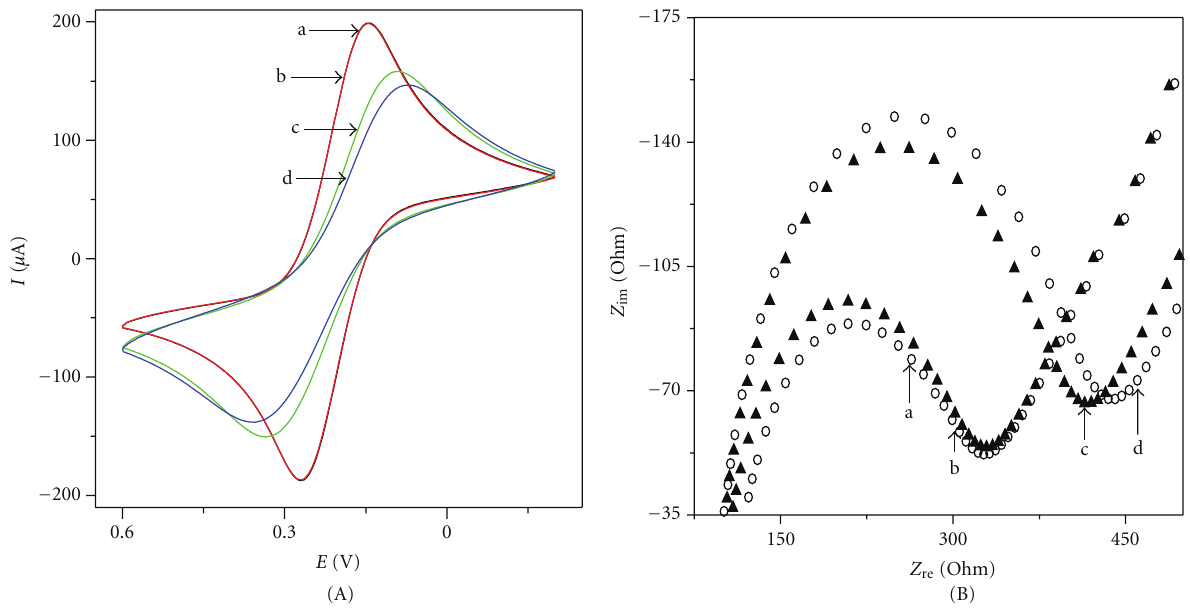
Figure 4: Cyclic voltammograms (A) and electrochemical impedance spectroscopy (B) of enantioselective responses: (a) and (b) (1R, 2R)- ADE-MPA modified Au electrode. (c) 5mM D-Trp reacted with the modified electrode. (d) 5mM L-Trp reacted with the modified electrode.